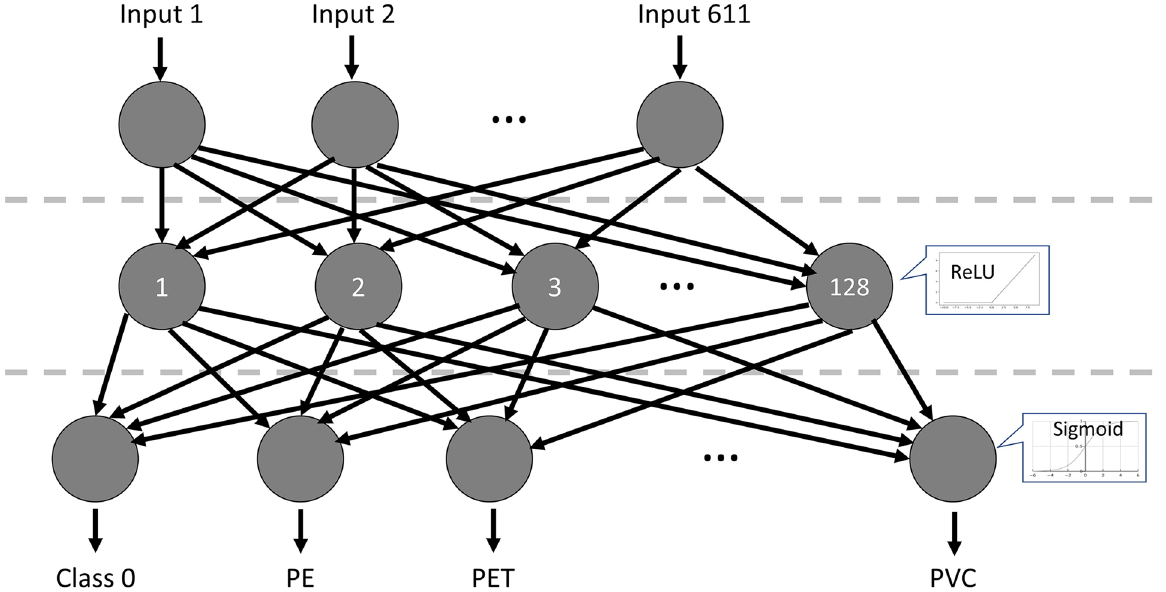
Fig. 5 Deep-learning model for all classes, with 128 fully connected hidden nodes and six